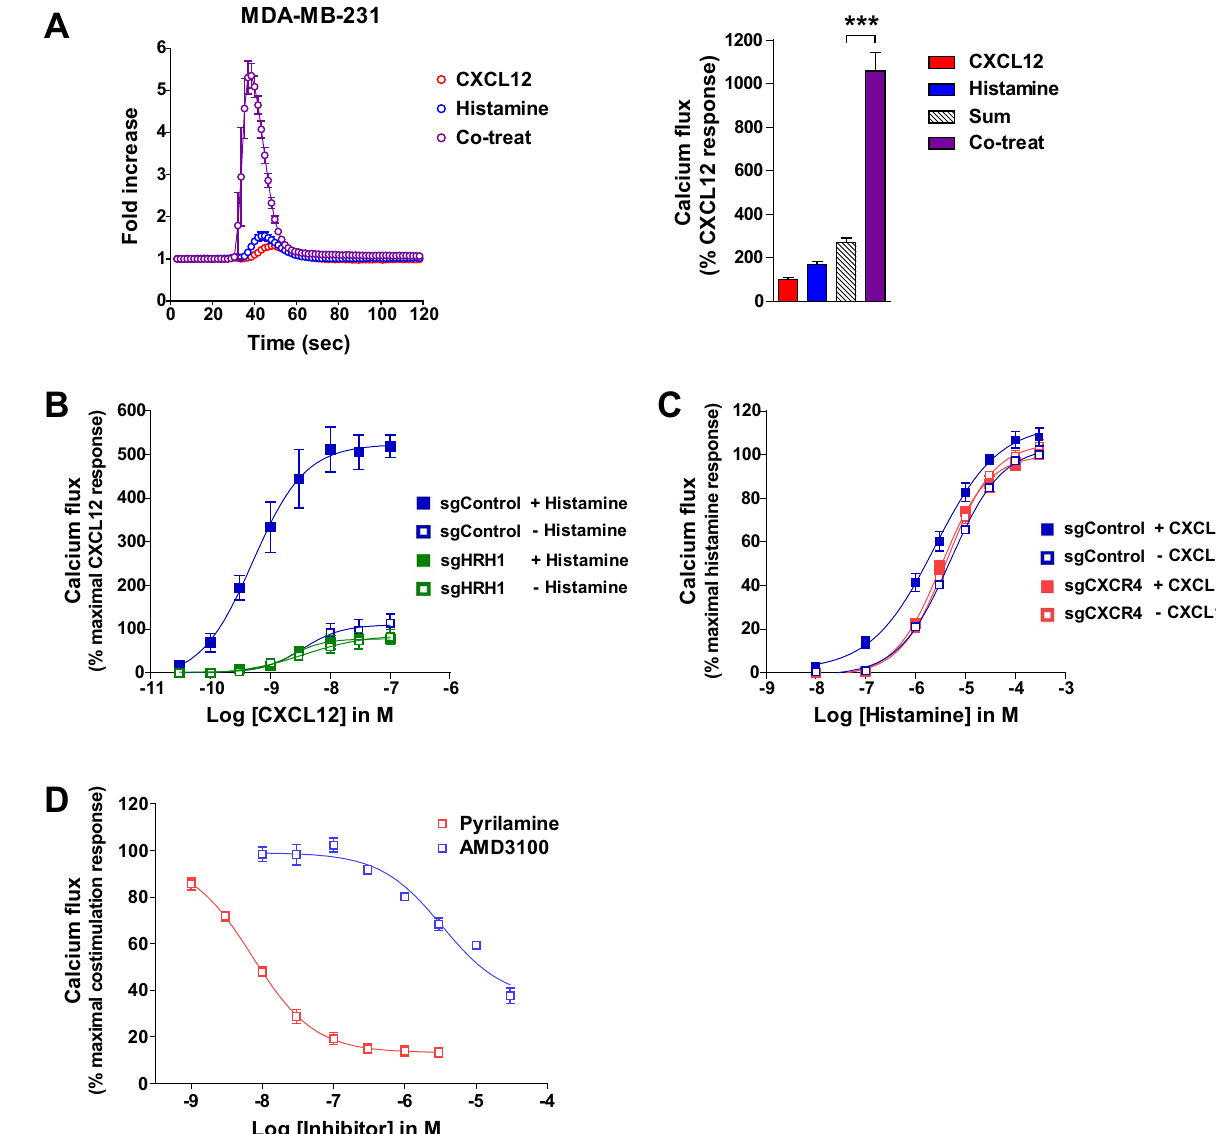
Figure 4. Costimulation of CXCR4 and HRH1 induces synergistic calcium mobilization in MDA-MB-231 cells. ( A ) MDA-MB-231 cells were stimulated with 3 nM CXCL12, 100 nM histamine, or both agonists at the same concentrations, and intracellular calcium flux was measured (left panel). The area under the curve of each calcium response was calculated and normalized to that of CXCL12 (right panel). Data are expressed as mean ± s.e.m. (n = 3). *** P < 0.001. ( B , C ) Synergistic calcium flux is mediated by CXCR4 and HRH1. Intracellular calcium flux was measured by stimulating HRH1 knockout (sgHRH1) or control (sgControl) cells with increasing concentrations of CXCL12 in the absence or presence of 100 nM histamine ( B ). Intracellular calcium flux was measured by stimulating CXCR4 knockout (sgCXCR4) or control (sgControl) cells with increasing concentrations of histamine in the absence or presence of 3 nM CXCL12 ( C ). Data are expressed as mean ± s.e.m. (n = 3–6). ( D ) Inhibition of the calcium response by the CXCR4 antagonist AMD3100 and the HRH1 antagonist pyrilamine. MDA-MB-231 cells were pretreated with increasing concentrations of AMD3100 or pyrilamine, and costimulated with 3 nM CXCL12 and 100 nM histamine. Data are expressed as mean ± s.e.m. (n =